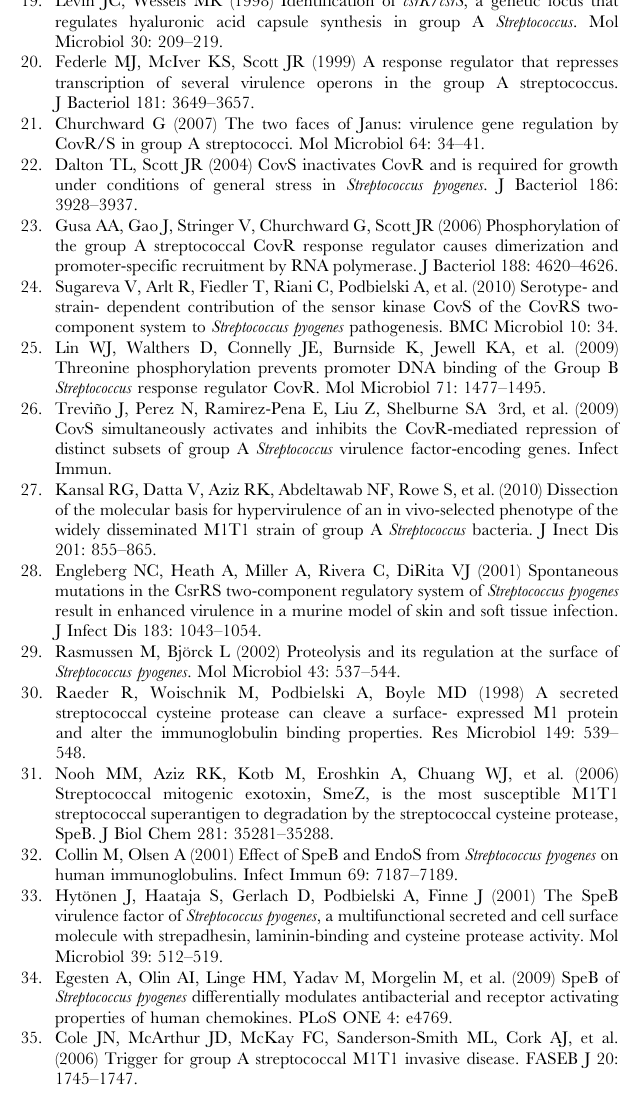
Figure S3 Microarray results summary statistics. Figure S4 A higher resolution version of Fig. 3. Because Fig. 3